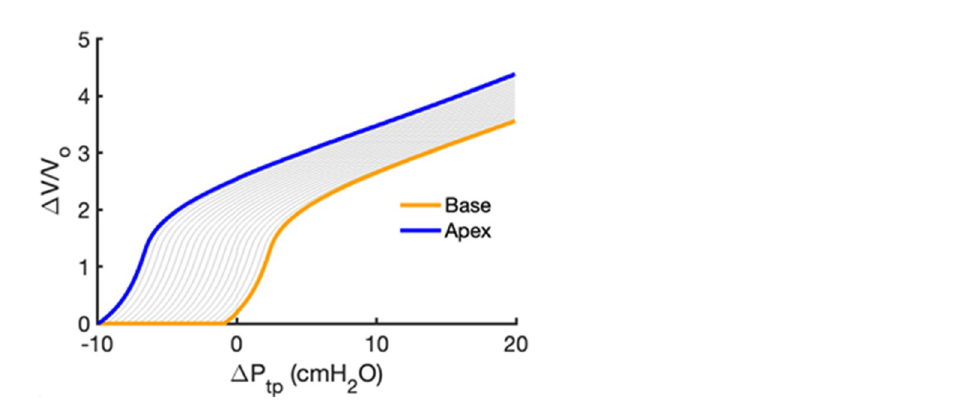
Figure 2. ( A ) The universal pressure–volume (P–V) curve of a single alveolus (gray line) between transalveolar pressures of P ta = 0 and 70 cmH 2 O. The orange and blue segments represent P–V curves of alveoli at the base and apex of the lung, respectively. The alveolus has an inherent minimum volume V 0 as P ta → 0 cmH 2 O. The volume change (cid:31) V , defined such that it is 0 when P ta = 0 , is normalized by V 0 . ( B ) Single alveolar P–V curves during inspiration (green) and expiration (red) including surface tension (ST) effects as well as viscoelastic collagen and waviness (see main text). For comparison, the deflation P–V curve without surface tension and viscoelasticity is also shown as a gray line.